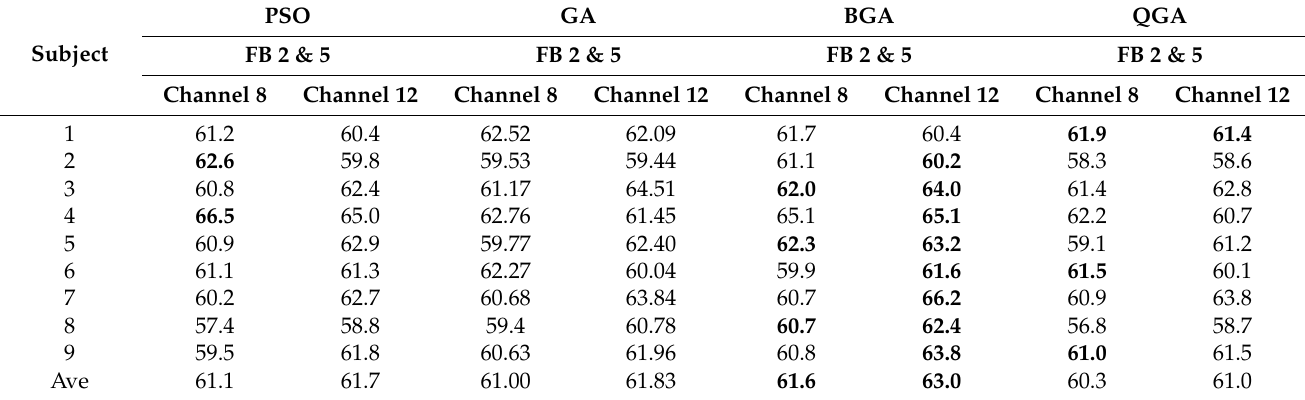
Table 9. Feature selection accuracy of PSO, GA, and BGA with 100 features, FB2 & 5, and ELM for 100 iterations.